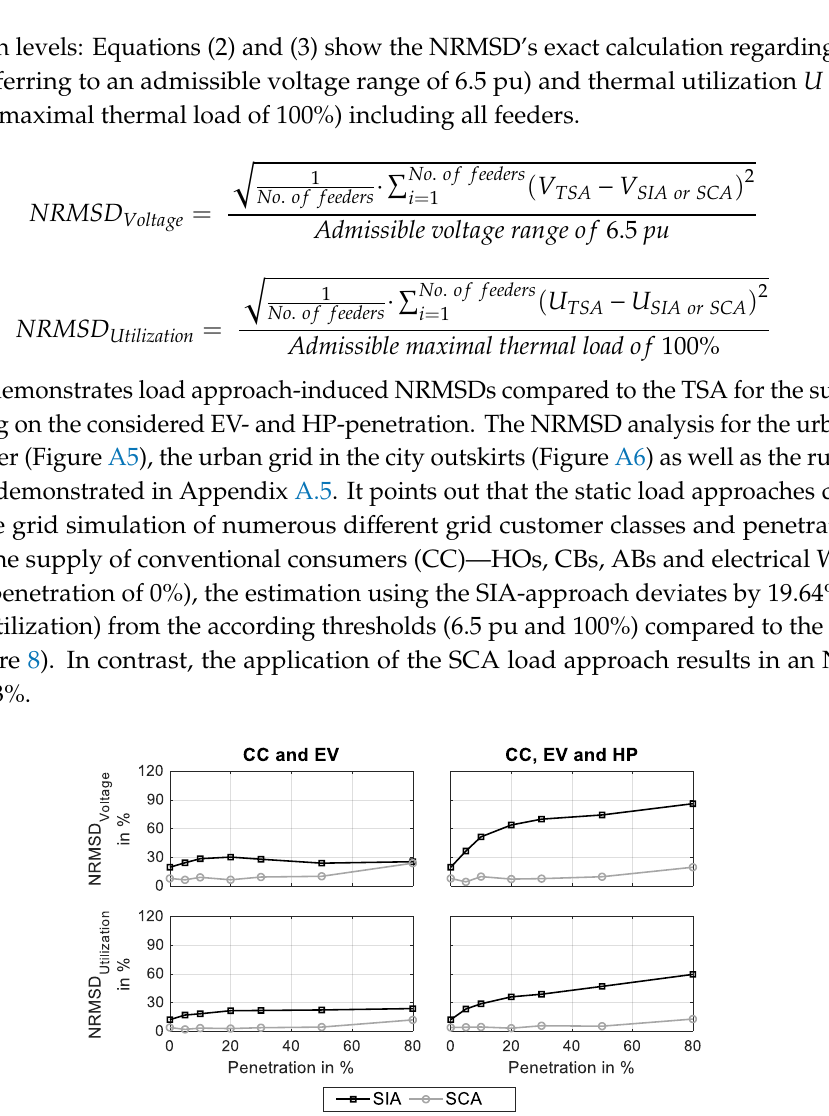
Figure 8. Load approach-induced normalized root mean square deviations (NRMSDs) compared to the TSA in terms of voltage characteristics and thermal utilization considering the suburban LV grid.